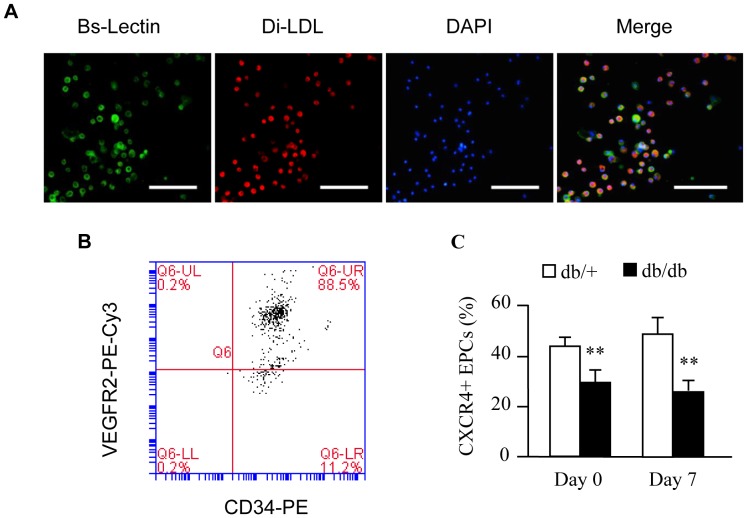
Characterization of bone marrow derived EPCs.(A) Representative pictures showing cultured EPCs by double staining analysis. Red: Di-LDL up-taking; Green: Bs-Lectin staining; Blue: DAPI (nuclear); Yellow: Di-LDL and Bs-Lectin positive cells defined as EPCs. Scale bar: 75 µm. (B) Representative flow plot showing the percentage of CD34/VEGFR2 expression in EPCs. At the end of EPC culture, cells were stained with CD34 and VEGFR2, and analyzed by flow cytometry. EPCs were defined as CD34+VEGFR+ cells. (C) Summarized data of CXCR4 expressing EPCs after day 0 and 7 days’ culture. **P<0.01 vs. db/+, n = 6/group.